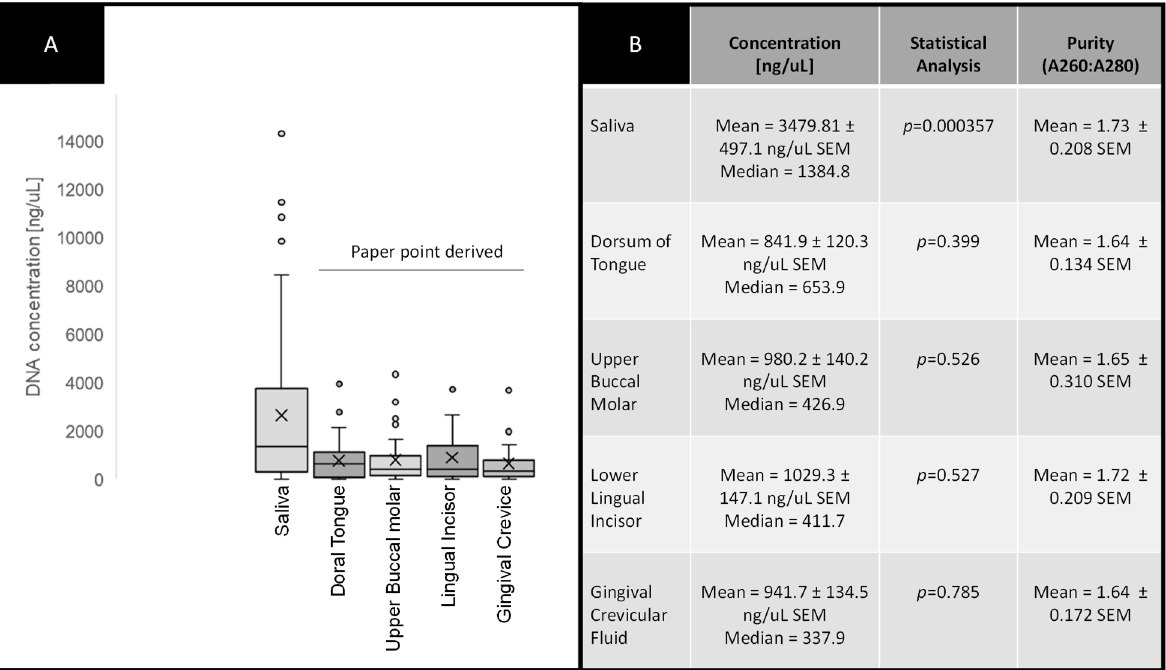
Figure 1. Analysis of DNA isolation. ( A ) Box-and-whisker plot of DNA concentrations from saliva and paper point sampling sites (dorsal tongue, upper buccal molar, lingual incisor, gingival crevice) demonstrates higher averages among saliva samples ( p = 0.000357). ( B ) Average DNA concentrations from paper point sampling sites were not significantly different from one another ( p = 0.399).